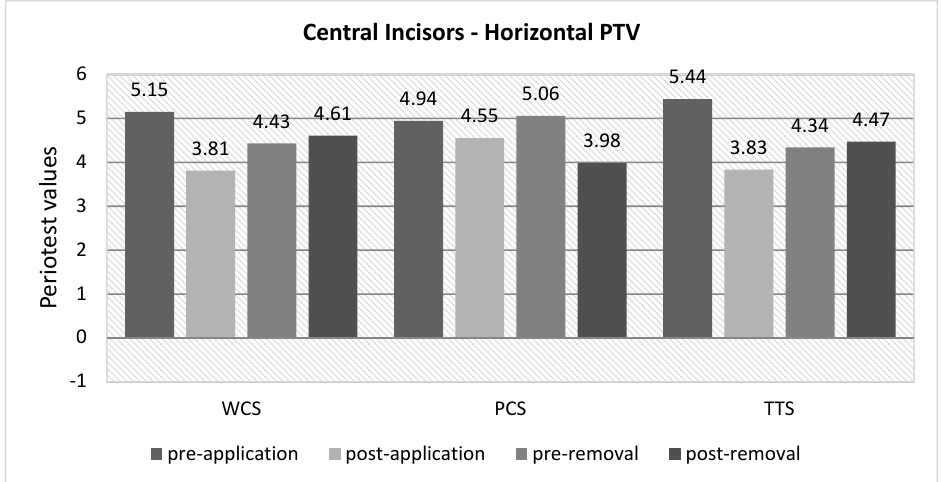
Figure 4. Horizontal Periotest values for central incisors.